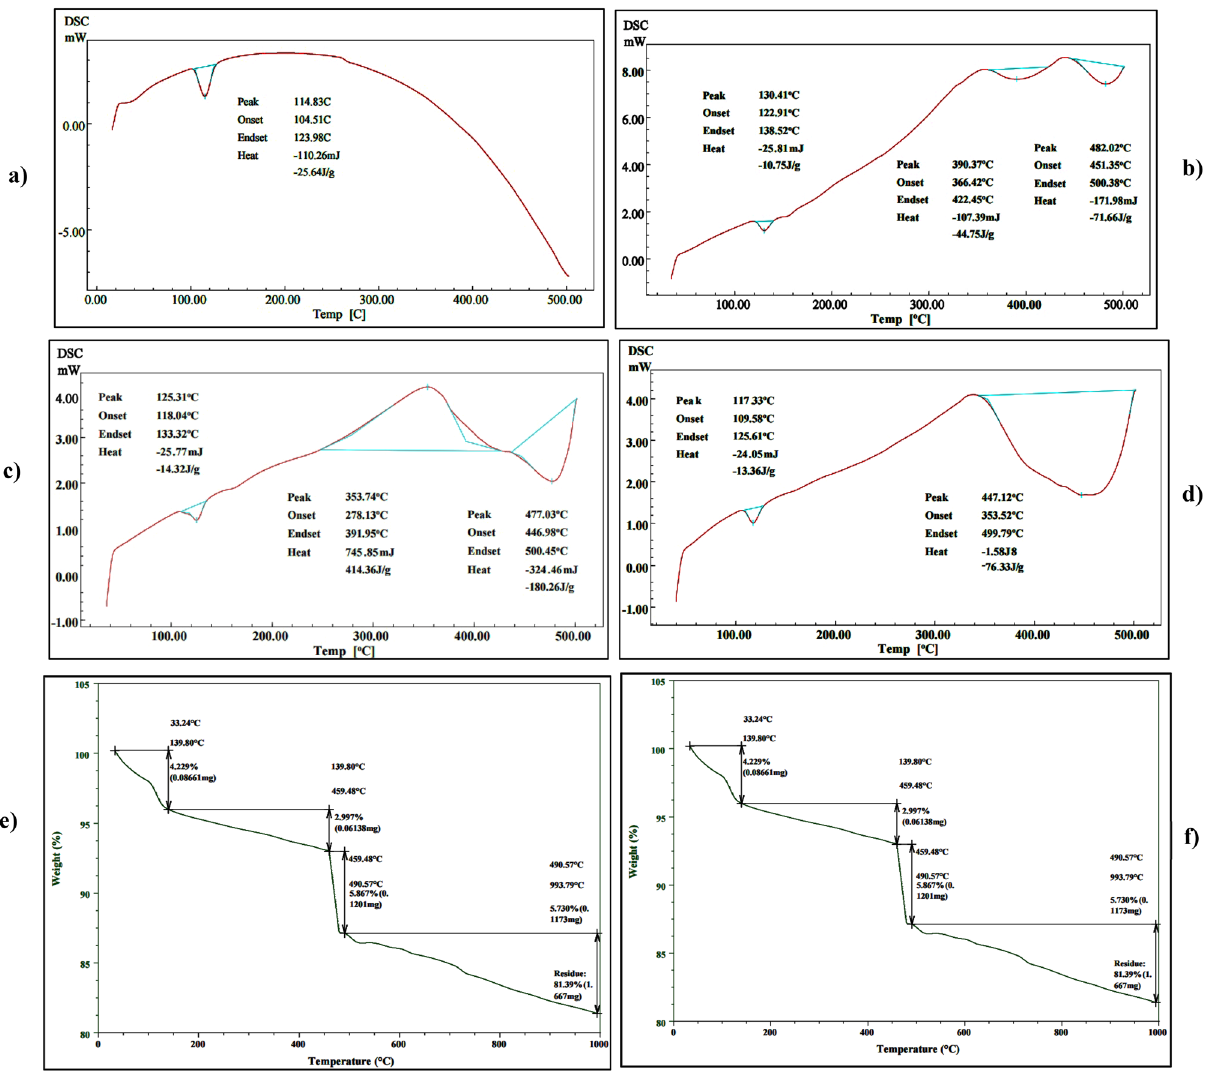
Figure 11. DSC analysis pattern for rock phosphate leftover samples, ( a ) at zero incubation time, ( b ) after 12 h of incubation time, ( c ) after 24 h of incubation time, ( d ) after 32 h of incubation time, ( e ) TGA analysis graph of rock phosphate leftover samples at zero incubation time, and ( f ) after 32 h of incubation